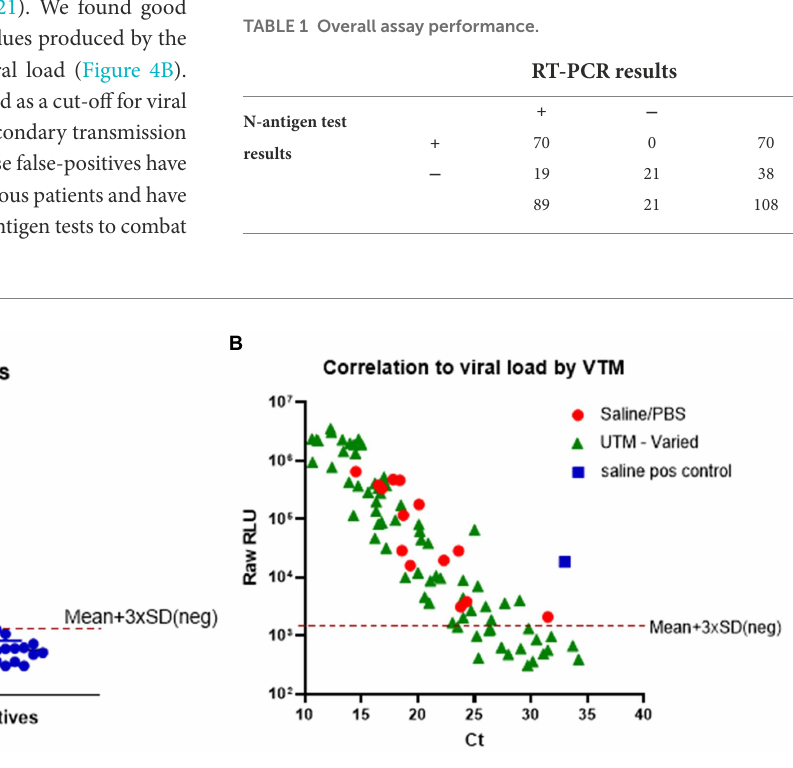
FIGURE 4 Detection of SARS-CoV-2 N-antigen in clinical samples. (A) Clinical samples that had previously been identified by PCR as negative ( n = 21) or positive ( n = 89) were individually tested in the N-antigen assay. (B) N-antigen assay raw RLU results were correlated to viral load (Ct) by VTM for all PCR positive samples ( n = 89). In both panels a and b, 30 ng/ml β 9-labeled anti-SARS-CoV-2 N mAb Cat. 9,547, 60 ng/ml β 10-labeled anti-SARS- CoV-2 N mAb Cat. 9,548, and 1 μ M LgTrip were incubated in the presence of sample for 90 min prior to the addition of Fz substrate and the measurement of luminescence. A red, dotted line has been added to each panel to represent a cut-off based on Mean + 3 × SD (neg). Statistical analyses determined by using an unpaired, non-parametric Mann–Whitney t-test.